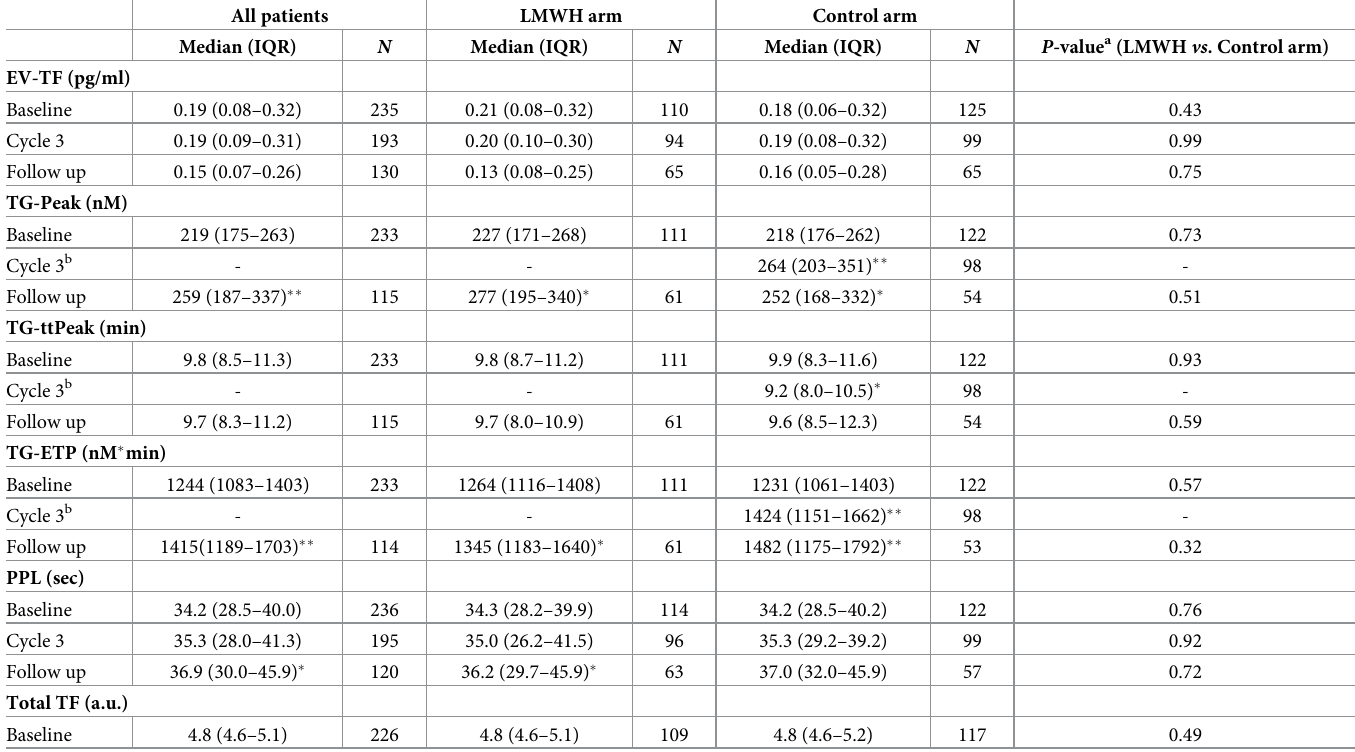
Table 2. Biomarkers at baseline, prior to cycle 3 and at 2 months’ follow up, for all patients and by treatment arm.